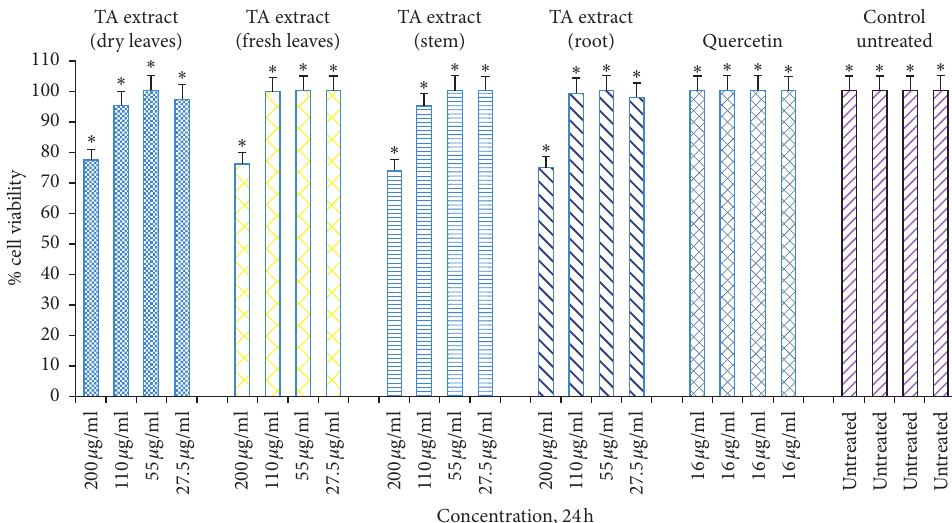
Figure 3: Cell viability determined by MTT assay. Hs27 skin fibroblasts were seeded at a density of 10,000 cells/well in 96-well plates and allowed to incubate overnight to attach to the surface. Next day, treat the cells with TA extracts (fresh and dry leaf, stem, and root extracts) for 24h along with quercetin as a positive control (16 μ g/mL) and control as untreated. Data shown as mean ± SEM; n � 3 and ∗ p < 0 . 05.